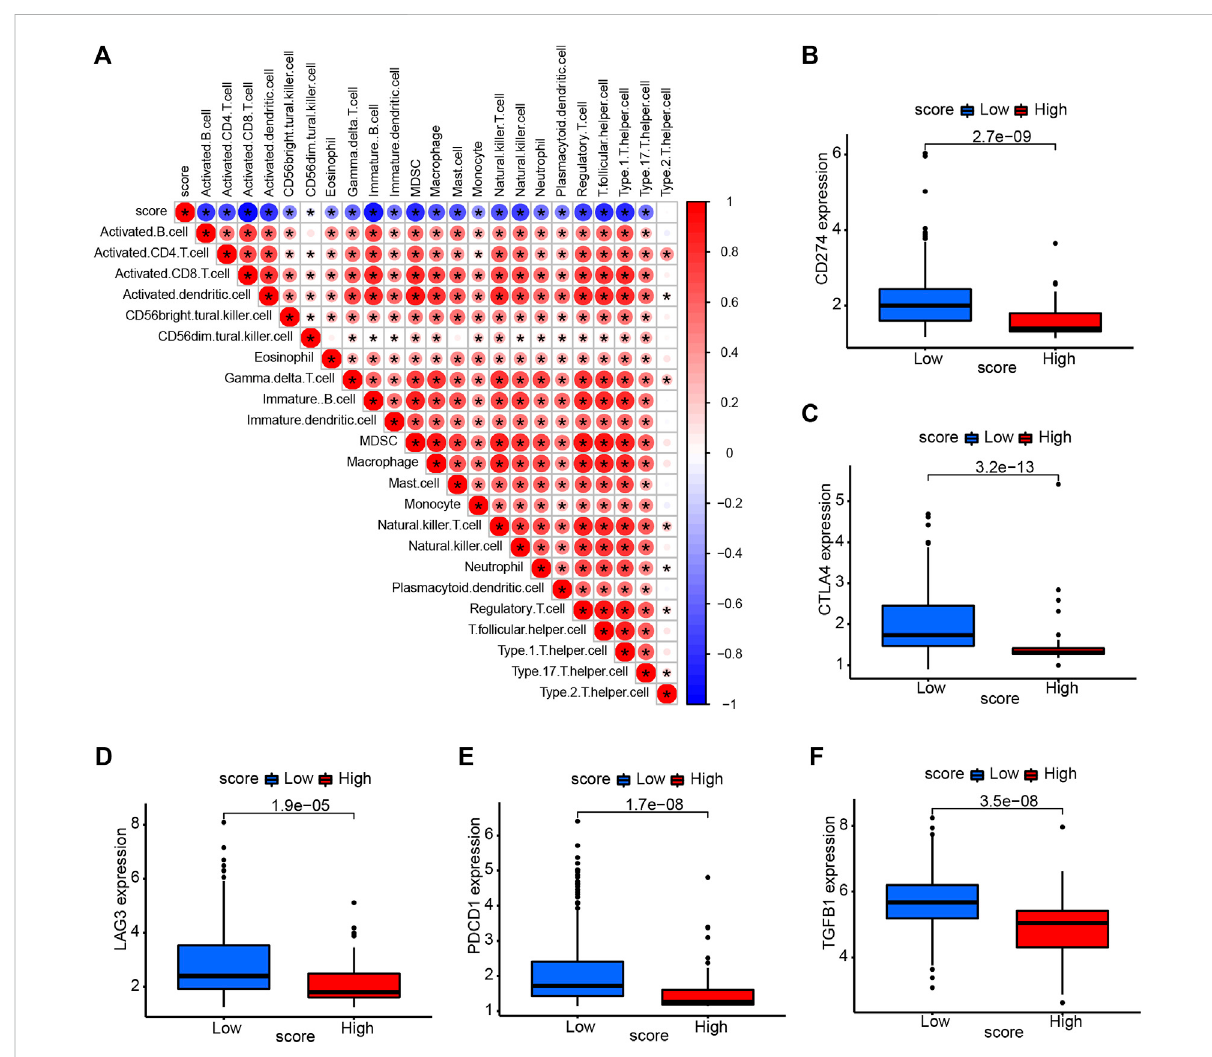
FIGURE 7 Associationofnecroptosisscoreandtumormicroenvironment. (A) Thecorrelationbetweennecroptosisscoreandimmunecellin fi ltration.Red color represents positive correlation, Blue color represents negative correlation. (B – F) The expression of immune checkpoints in high- and low- necroptosis score